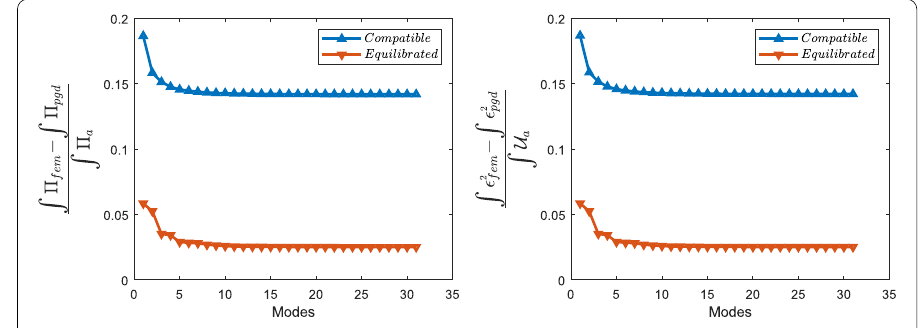
Fig. 6 Relative difference between the PGD and FEM integral of the solutions energies and the average total absolute energy of the FEM solution (left). Relative difference between the PGD and FEM integral of the error energies and the average strain energy of the FEM error (right)